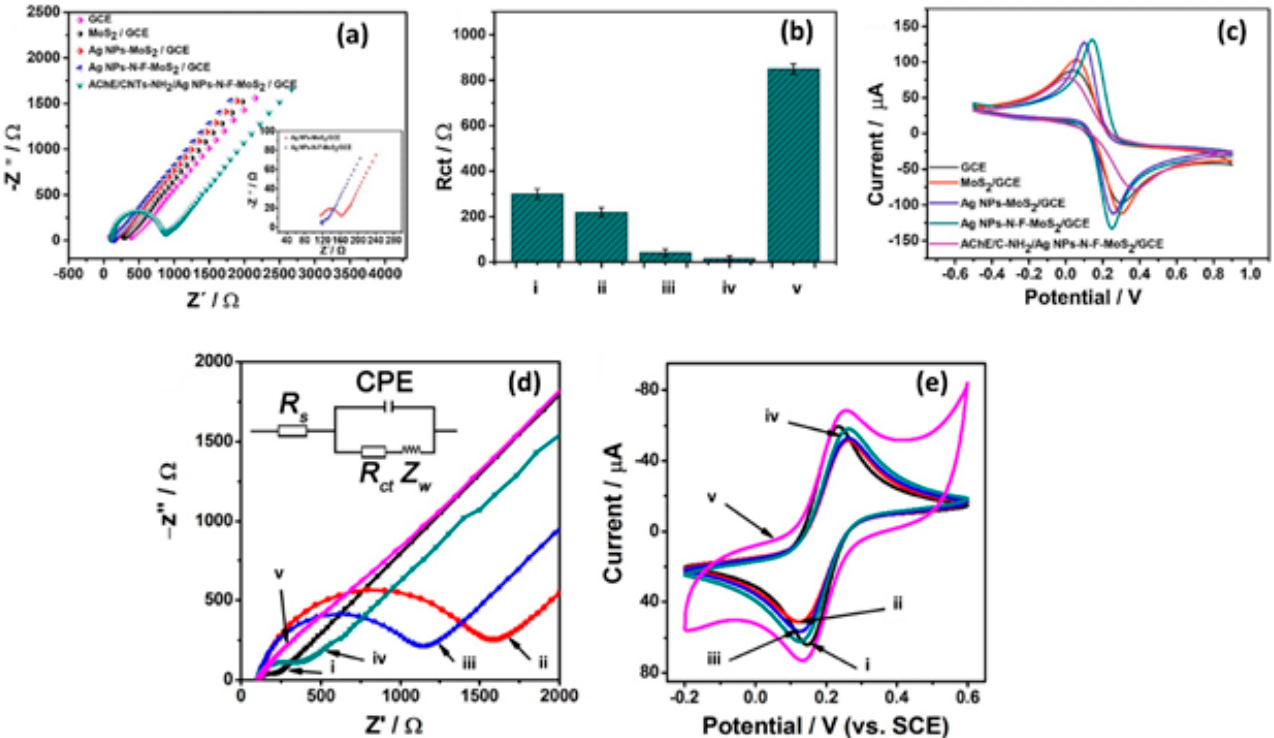
Figure 5. ( a ) EIS response of bare and modified electrodes with a frequency range from 0.01 to 100 kHz, with an amplitude of 5 mV. ( b ) The histogram for R CT of (i) bare/GCE, (ii) MoS 2 /GCE, (iii) Ag NPs ‐ MoS 2 /GCE, (iv) Ag NPs ‐ N ‐ F ‐ MoS 2 /GCE, (iii) AChE/CNTs ‐ NH2/Ag NPs ‐ N ‐ F ‐ MoS 2 /GCE. Error bars are coefficients of variation across three repetitive experiments. ( c ) CV response of bare and modified electrodes at a scan rate of 100 mV s − 1 [88], ( d ) EIS and ( e ) CV responses of (i) bare/GCE, (ii) MoS 2 /GCE, (iii) Au ‐ MoS 2 /GCE, (iv) Pd ‐ MoS 2 /GCE, and (v) Au ‐ Pd ‐ MoS 2 /GCE [89]. Figures reproduced with permission from Ref. [88] copyright © 2018 Elsevier B.V, and Ref. [89] copyright © 2016 Elsevier B.V.